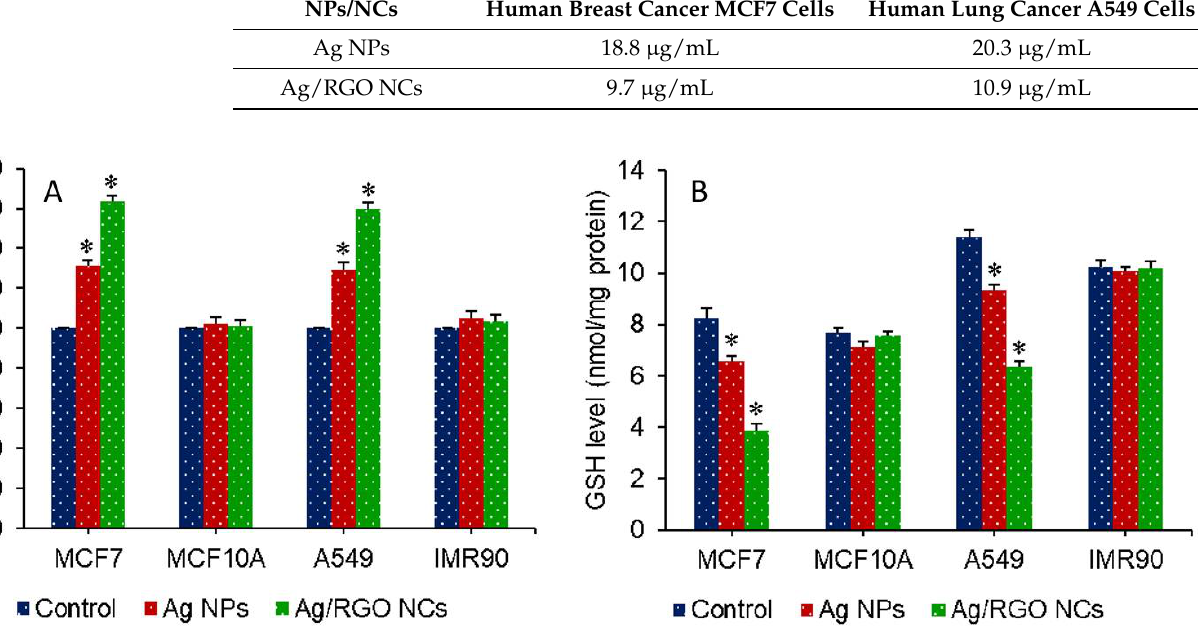
Figure 9. Oxidative stress response of cancer and normal cells against 10 µ g/mL of Ag NPs and Ag/RGO NCs for 24 h: ( A ) ROS generation; ( B ) GSH depletion. * p < 0.05 statistically different from